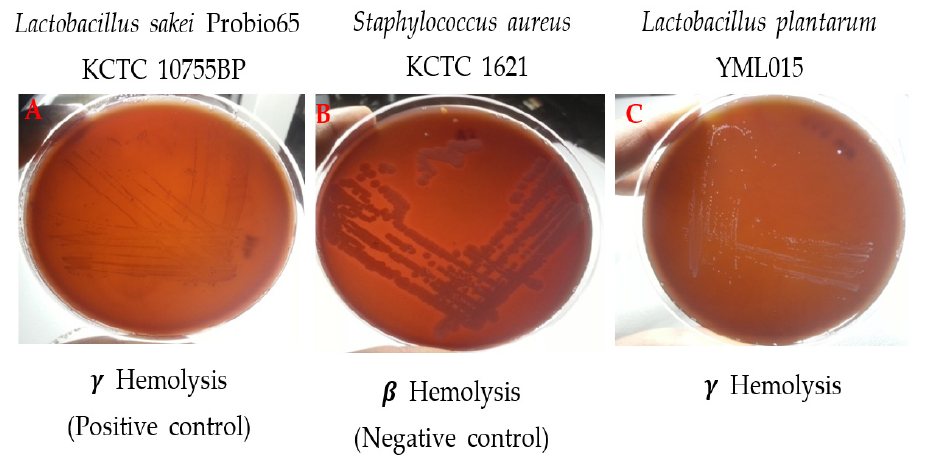
Figure 3. ( A ) Hemolytic phenomenon assay. Positive control: Lactobacillus sakei Probio 65 γ hemolysis; ( B ) Negative control Staphylococcus aureus KCTC 1621 β hemolysis (negative control); ( C ) Tested strain L. plantarum YML015 γ